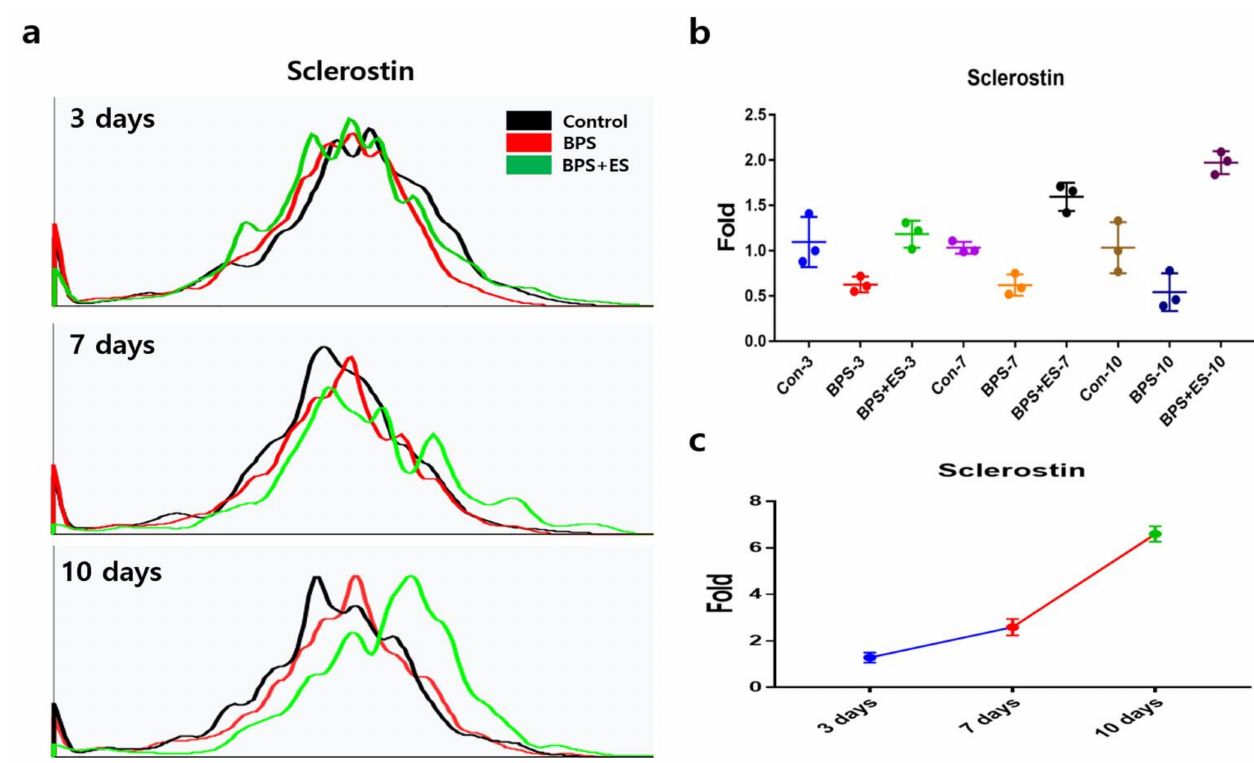
Figure 6. Protective effect on osteoblast differentiation by black jade extract in adipose-derived stem cells (ASCs) under conditioned mediums. These results are from ASCs under conditioned mediums (BPS, BPS+EX). ( a ) Graphs indicating sclerostin cell counts detected using flow cytometry. ( b ) Relative fold changes for sclerostin cell counts. ( c ) Relative fold changes between BPS and BPS+ES. BaP+ES means that ASCs were exposed to BPS after treatment using ES. The conditioned medium (BPS) contained the supernatant from the fibroblast cells exposed to benzo(a)pyrene. The conditioned medium (ES) contained the supernatant from the fibroblast cells exposed to the extract. Con; Control, ( p < 0.05, n =